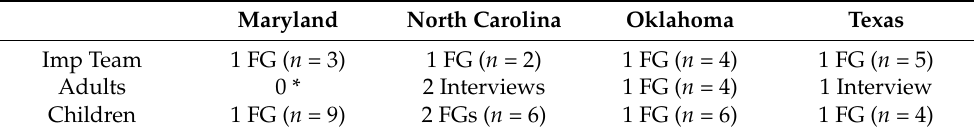
Table 2. Post Play Streets focus group and interview descriptive